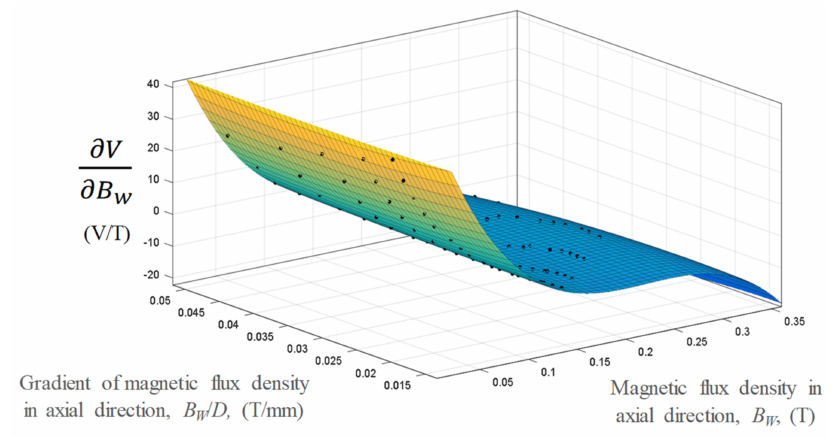
Figure 14. Sensitivity analysis of the variation in B w -V with B w /D and B w .